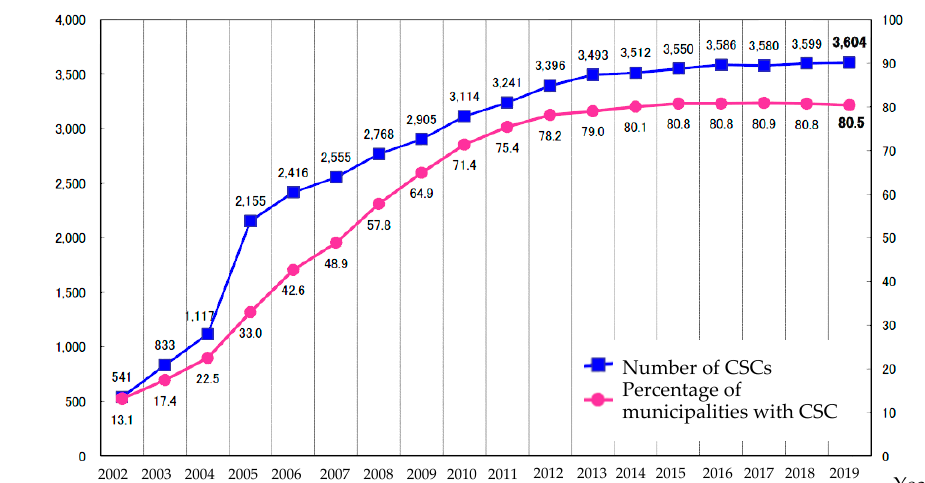
Figure 1. Development of community sports club in Japan, 2002 − 2019.